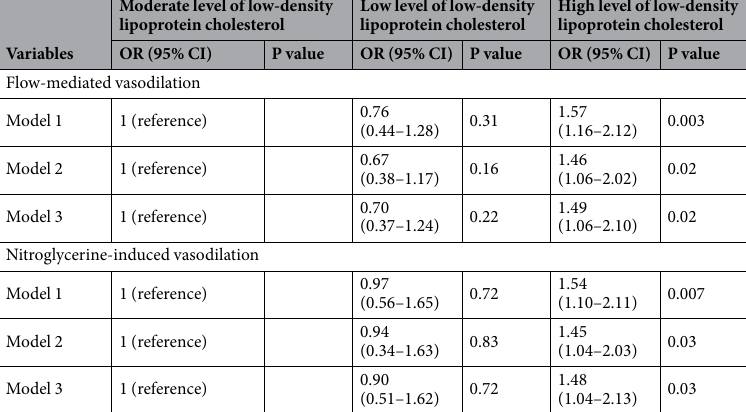
Table 4. Multivariate Analysis of the Relations between Vascular Dysfunction and Low-Density Lipoprotein Cholesterol. Low tertile of flow-mediated vasodilation indicates less than 2.7%. Low tertile of nitroglycerine- induced vasodilation indicates less than 10.6%. Model 1: unadjusted model. Model 2: adjusted for age, gender. Model 3: adjusted for age, gender, body mass index, current smoking, presence of hypertension and diabetes